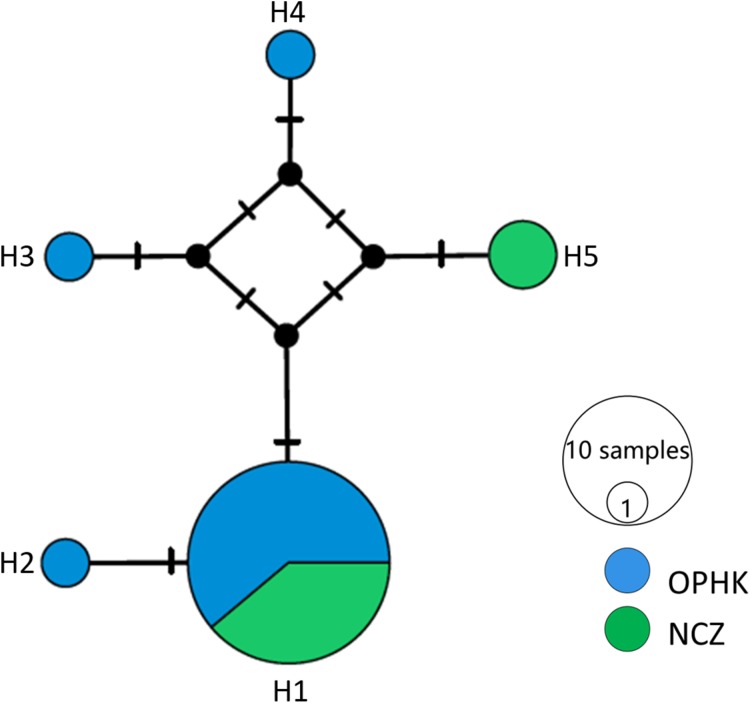
Haplotype network analysis results for the cytb gene dataset (1,017 bp) of Blue-crowned Laughingthrush.Black lines on branches indicate the inferred number of mutation steps between haplotypes or ancestral haplotypes. Circle size is proportional to the number of individuals with a particular haplotype. Abbreviations indicate different Blue-crowned Laughingthrush populations (OPHK, Ocean Park Hong Kong; NCZ, Nanchang Zoo).